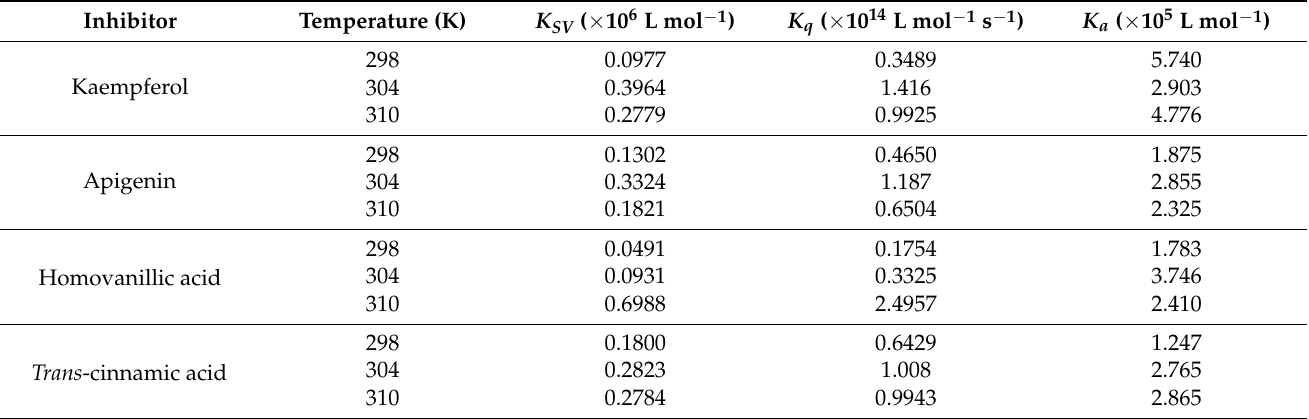
Figure 5. Stern-Volmer plots for fluorescence quenching of XO by ( a ) kaempferol, ( b ) apigenin, ( c ) homovanillic acid, and ( d ) trans -cinnamic acid at different temperatures. Table 2. Quenching constant K SV , quenching rate constant K q , and modified Stern-Volmer association constant K a for the interaction between the inhibitors and XO at different